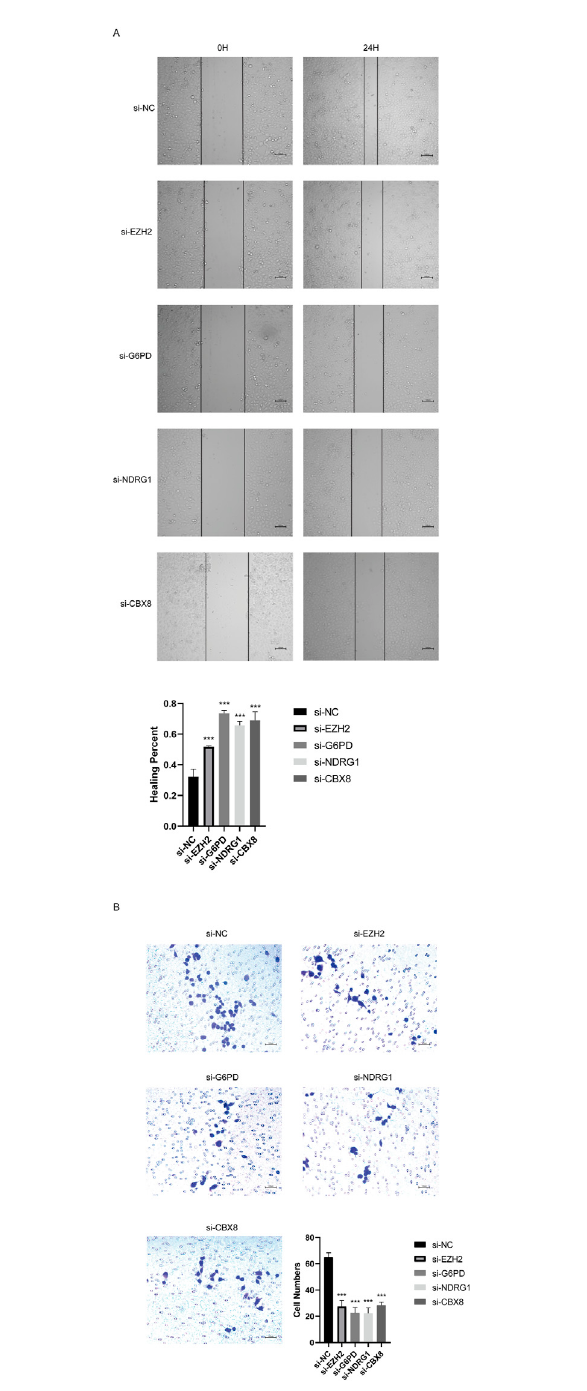
FIGURE 10 CSGs inhibits SMMC-7721 cells migration, and invasion in vitro . (A) Silencing4CSGsattenuatedwoundclosurecorroboratedinSMMC-7721 ( n = 3). (B) Silencing 4 CSGs attenuated wound closure corroborated in SMMC-7721. The error bars indicate the mean ± SD, and each experiment was repeated at least three times. * p < .05, ** p < .01, *** p < promotes HCC development by inhibiting ferroptosis through targeting cytochrome P450 oxidoreductase (Cao et al., 2021). Consistently, our study showed knockdown of G6PD evidently suppressed HCC cell migration and invasion. CBX8 inhibits stress-